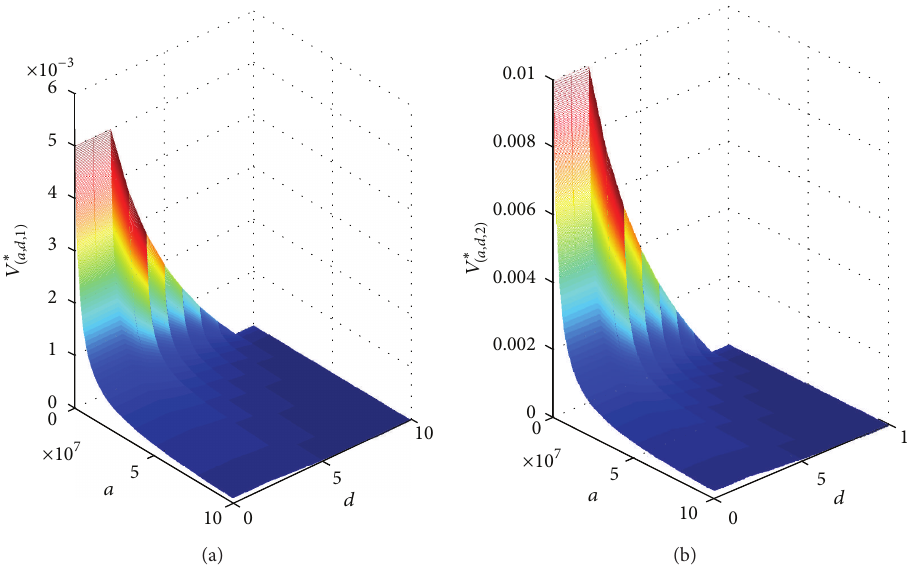
Figure 3: Whittle index values obtained from AG -algorithm for two channel conditions and different attained services and delays. For a Pareto distribution with 𝛼 = 1.5 and E [𝑋] = 5 Mb, 𝑞 2 = 0.5 , 𝑟 1 = 8.4 Kb, 𝑟 2 = 16.8 Kb, 𝑑 min = 2 s, and 𝑑 max = 9 s.